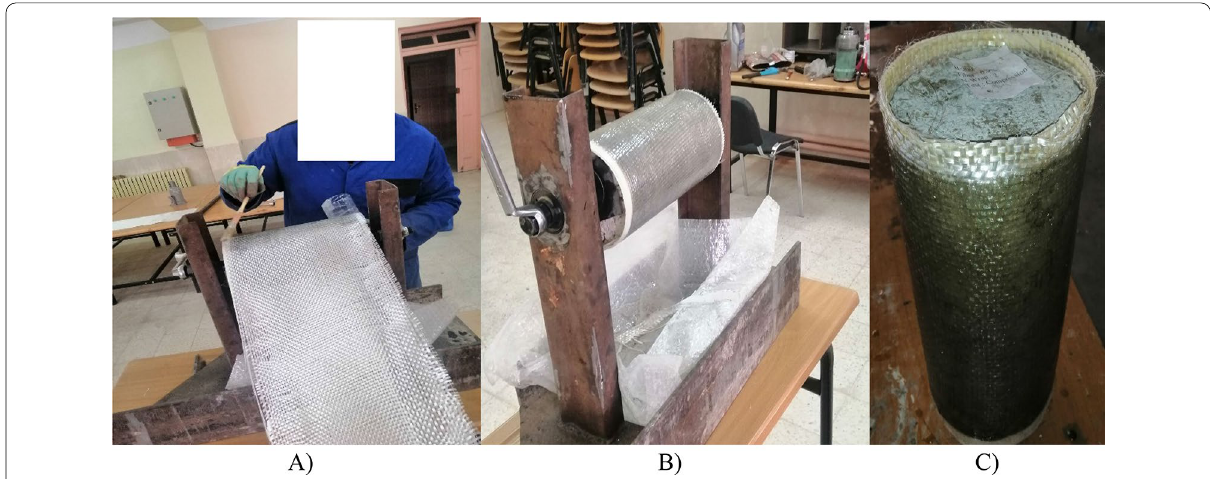
Fig. 3 A , B Application of resin on the concrete and glass fiber wrapping, and C typical GFRP strengthened